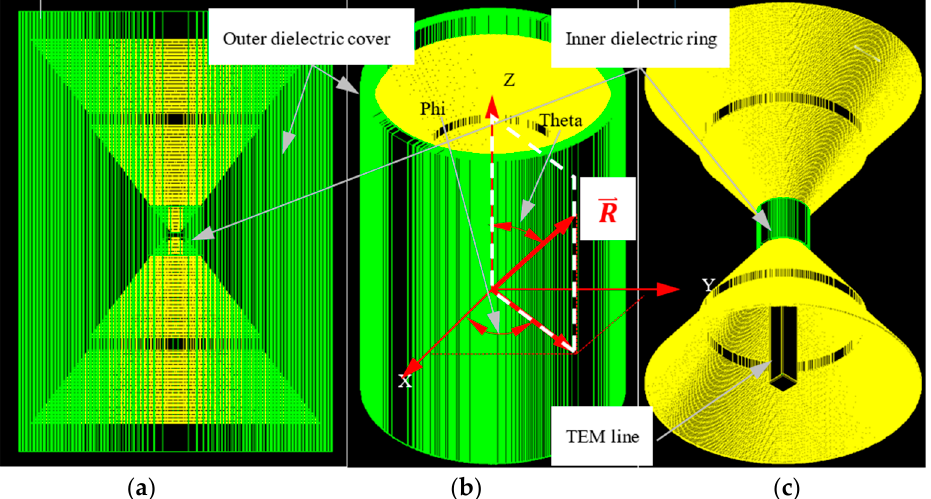
Figure 4. ( a ) A front wireframe view of the base-modified biconical antennas (MBA) with stair-cased inner dielectric ring (in green color) and outer dielectric cover (also in green color); ( b ) an isometric view of the base MBA (looking from an upper angle) with XYZ-coordinate system, a [phi theta] angle-pair shows the direction of the vector parallelogram shows a portion of the phi-cutting plane, on which 2D radiation pattern is calculated in Sections 3 and 4; ( c ) an isometric view of the base MBA without outer dielectric cover (looking from a lower angle). All dielectric materials have ε r =